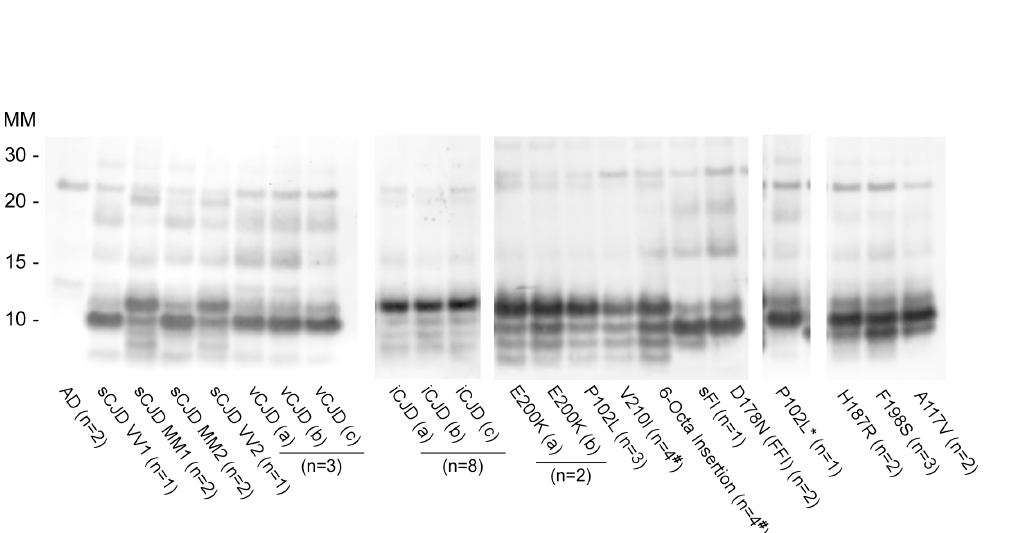
Fig 5. Western blot of BV rPrP Res products from RT-QuIC reactions seeded with various human prion types. Reaction products were digested with 10 μ g/mL of PK. Immunoblots were probed with the C-terminal antibody R20 (hamster PrP epitope residues 218 – 231). Molecular mass (MM) is indicated in kilodaltons. Immunoblots are representative of one biological replicate (n = total biological replicates tested) each giving rPrP Res banding profiles similar to that/those shown. (#) Samples for which cerebellum, frontal cortex, basal ganglia and thalamus from the same patient were analyzed. A minimum of two sets of RT-QuIC bank vole rPrP Res products were generated from a given prion type and independently subjected to immunoblotting analysis.